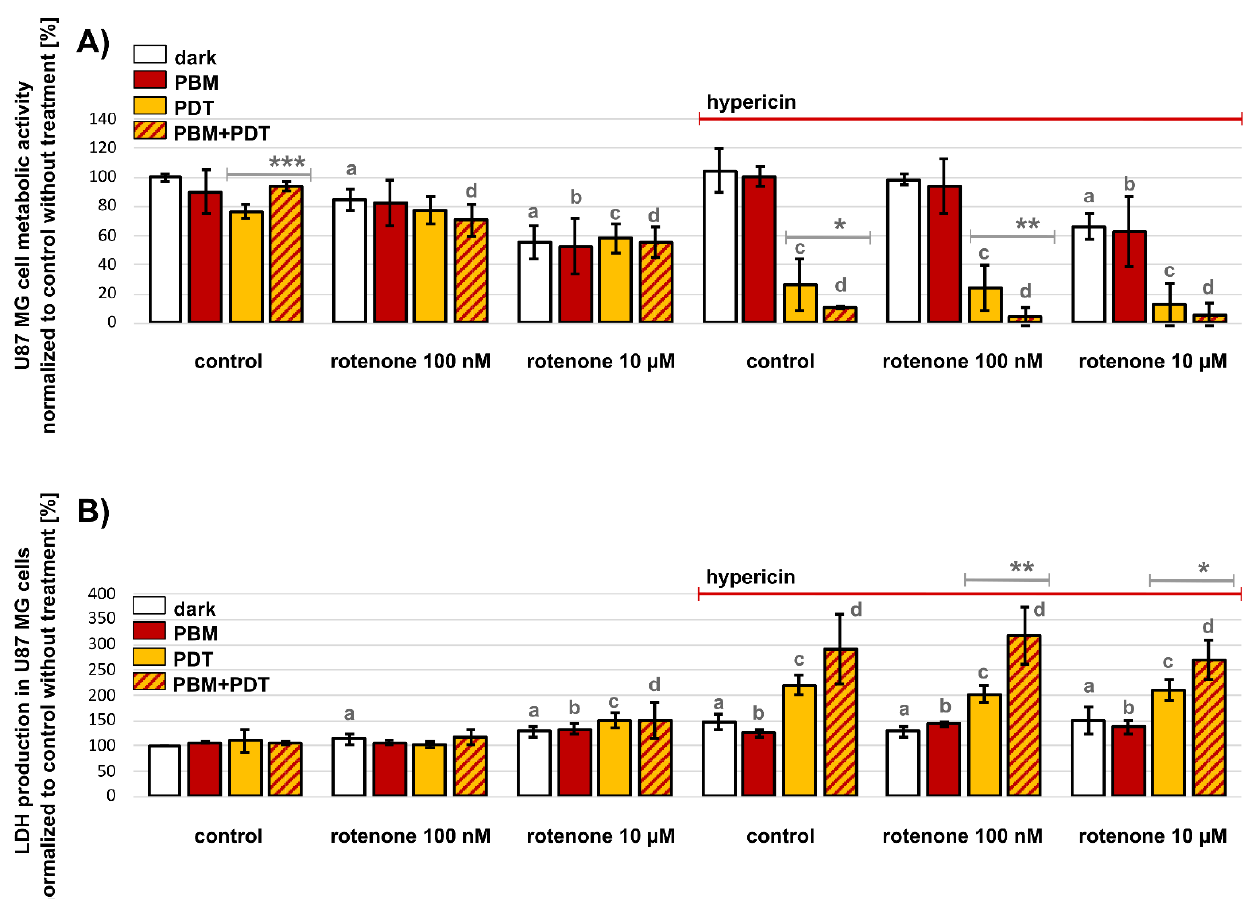
Figure 2. ( A ) Metabolic activity of U87 MG cells and ( B ) LDH activity in the dark (white columns), after PBM (red columns), hypericin-PDT (orange columns) and PBM-hypericin-PDT (orange columns with red patterns). Hypericin concentration was 500 nM (administered to cells for 3 h). Cell damage was also induced by 100 nM and 10 µ M rotenone for 24 h. Significance level (against controls without hypericin treatment) was estimated using the one-way ANOVA-test: a (dark), b (PBM), c (PDT), d (PBM + PDT) < 0.05, * p < 0.05, ** p < 0.01, *** p < 0.001.